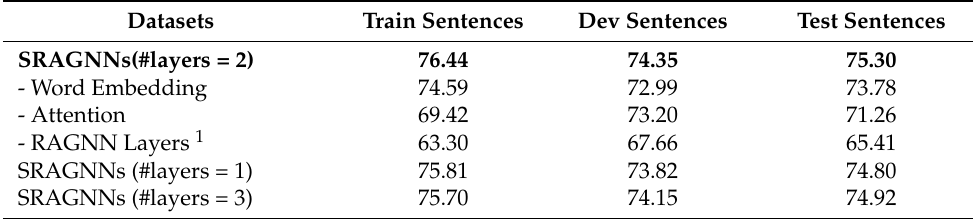
Table 7. Ablation study of SAAGNNs on CEMR